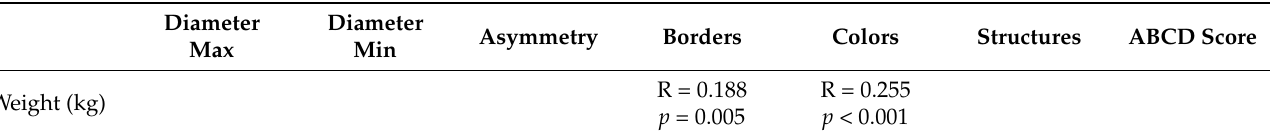
Table 4. Correlation coefficients between variations in the auxological with respect to the morpholog- ical